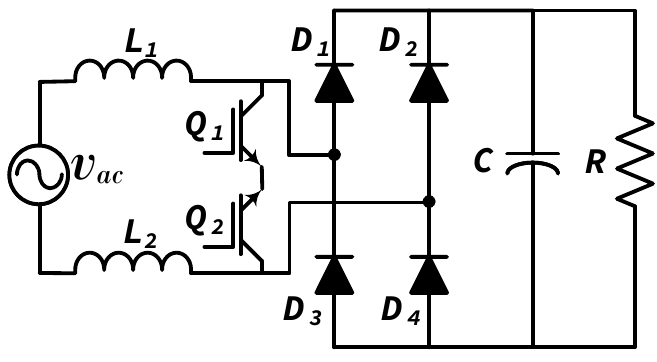
Figure 5. Conventional PFC topology with a bidirectional switch. Different configurations were proposed to enhance the performance of the bidirec- tional BBC topology [83,87]. The PFC Topology with Bidirectional and flexible switches is depicted in Figure 6a. This converter includes ( Q 3 and Q 4 ) as auxiliary switches and also a split DC link bus configuration ( C 1 and C 2 ). Q 3 and Q 4 allow supplying the converter with two levels of input voltage, and both auxiliary switches are open or closed at the same time facilitating the control strategy. This converter is only recommended for low voltage and power applications since the bidirectional switches increase power losses and need a robust soft switch circuit for the management of high currents. The BBC PFC Interleaved Topology with Bidirectional switch is depicted in Figure 6b. This converter is only suggested for low voltage and low power applications since it requires a great quantity of semiconduc- tors that need independent soft switching, isolation, and drivers—so that conventional interleaved (Section 2.2) BBC complies with the same function with less components and control complexity.